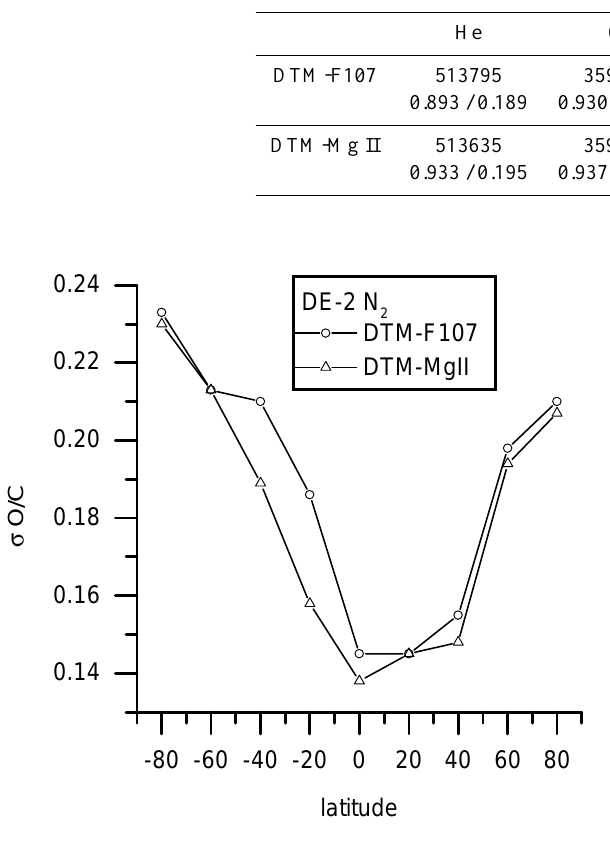
Fig. 8. The scatter of the DE-2 helium residuals presented in alti- tude